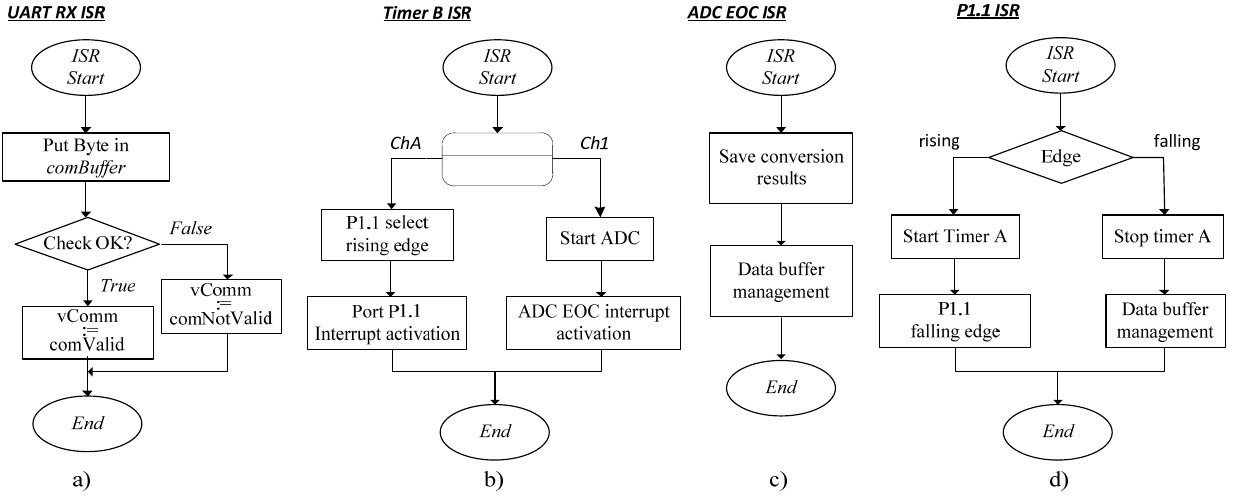
Figure 6. Flowchart of the service routines: ( a ) serial communications; ( b ) data conversion; ( c , d ) Data store and buffer